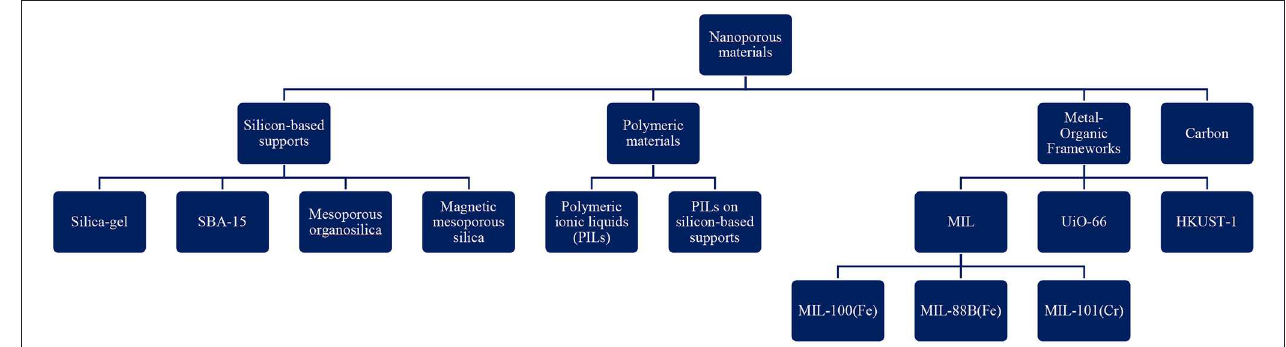
FIGURE 1 | Classification of nanoporous materials used as supports for ILs in (trans)esterification reaction (SBA, Santa Barbara Amorphous; PILs, Polymeric ionic liquids; MIL, Materiaux de l ′ Institute Lavoisier; HKUST, Hong Kong University of Science and Technology; UiO, Universitetet i Oslo).